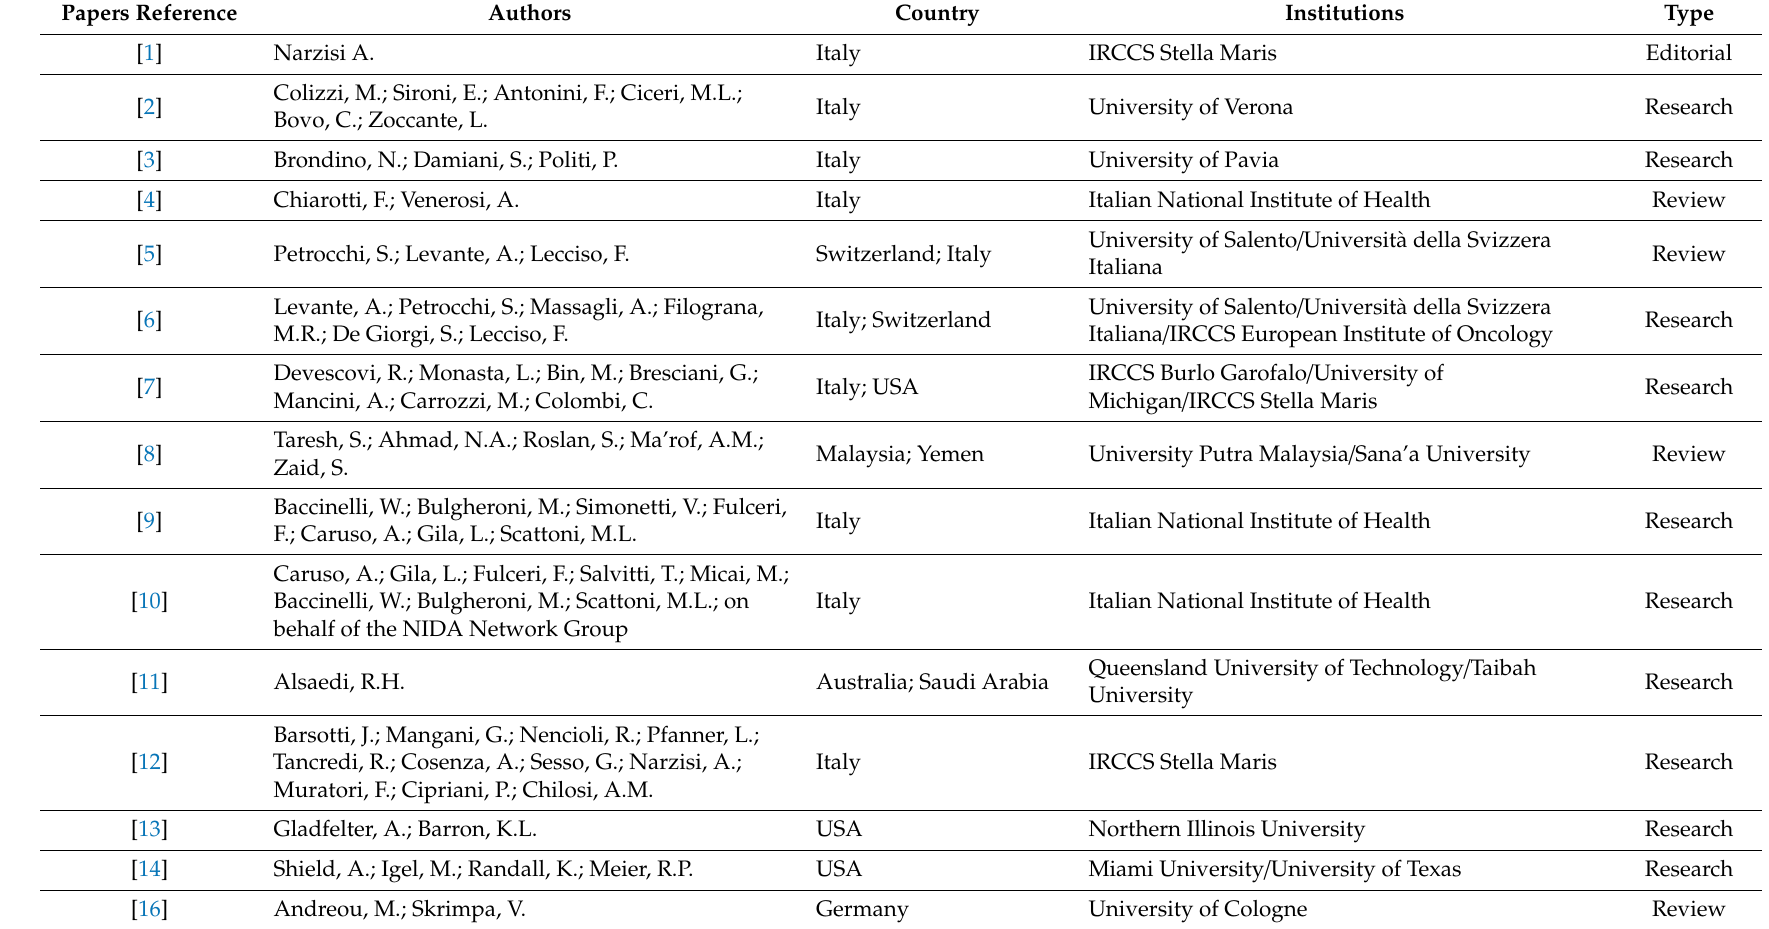
Table A1. Authors, Countries, Intitutions and Type of the papers included in the Special Issue “Advances in Autism Research”. Papers